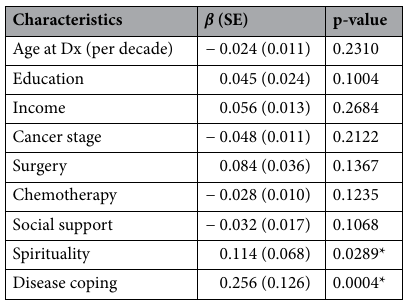
Table 4. Predictors of BFS trend patterns by multivariate linear model (N = 486). * p ≤